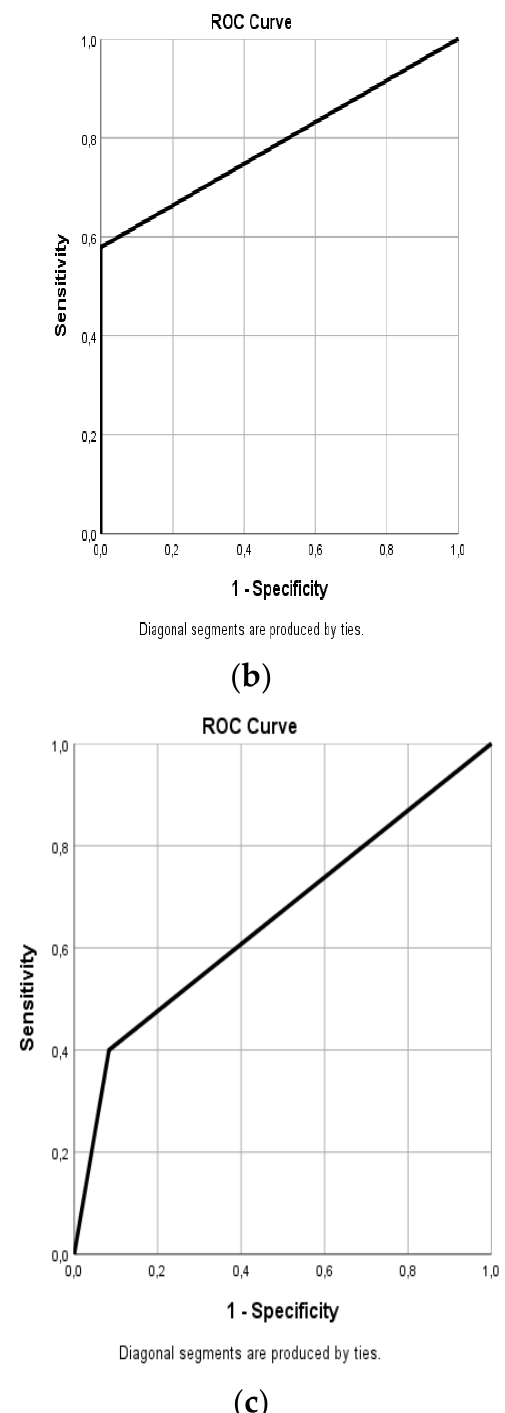
Figure 3. Receiver operating characteristic analysis curves of the US, MRI, and F18-FDG-PET/CT combinations. ( a ) US + MRI AUC:0.629. ( b ) USG + F18-FDG-PET/CT AUC:0.789. ( c ) F18-FDG- PET/CT + MRI AUC:0.658